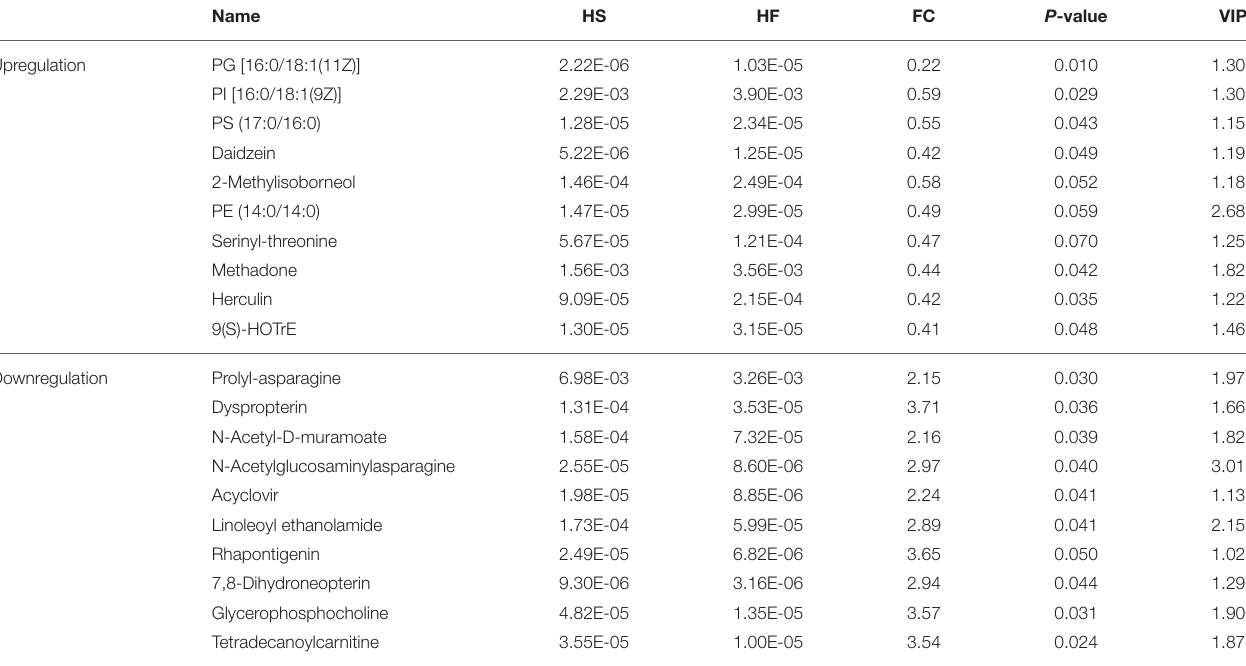
TABLE 9 | Ruminal metabolite alterations to the honeycomb flavonoids supplement under heat stress conditions.